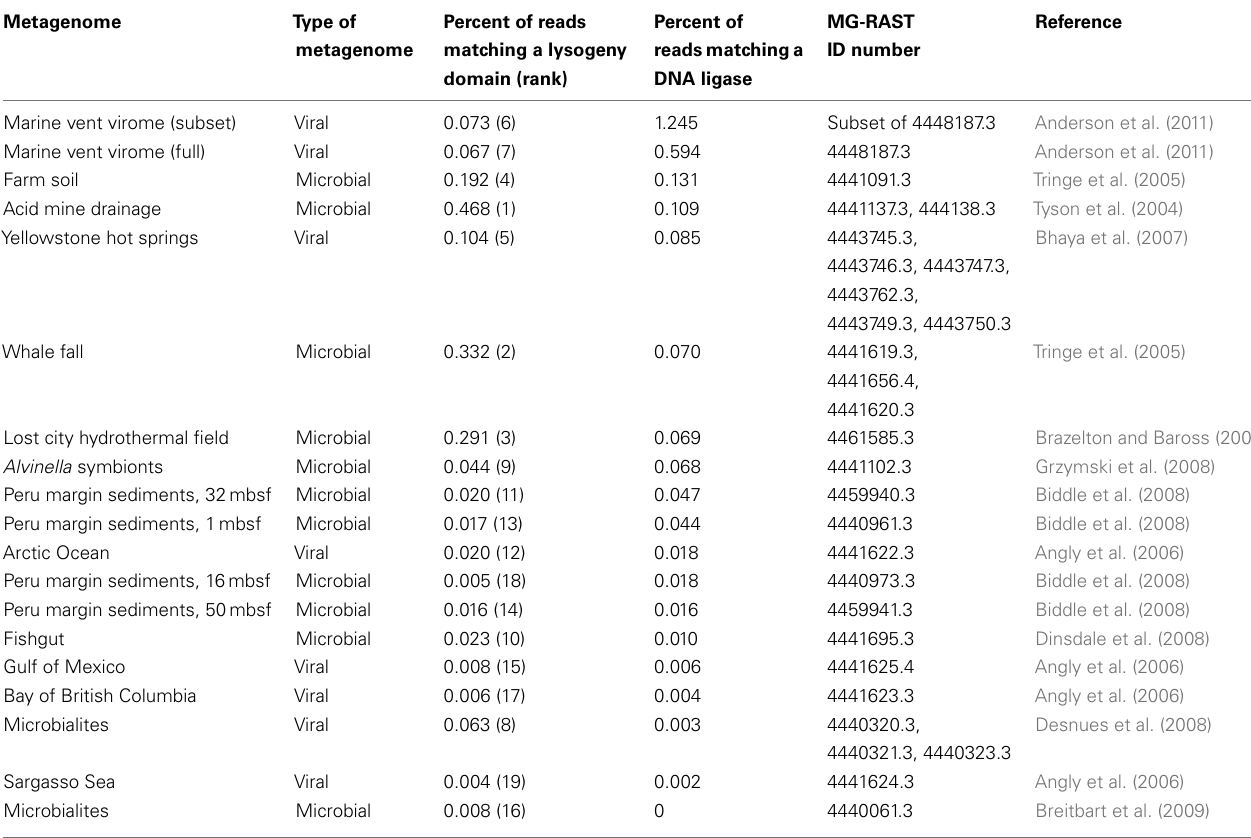
Table 3 | Percent of reads matching a DNA ligase and a transposase domain in 19 sequenced